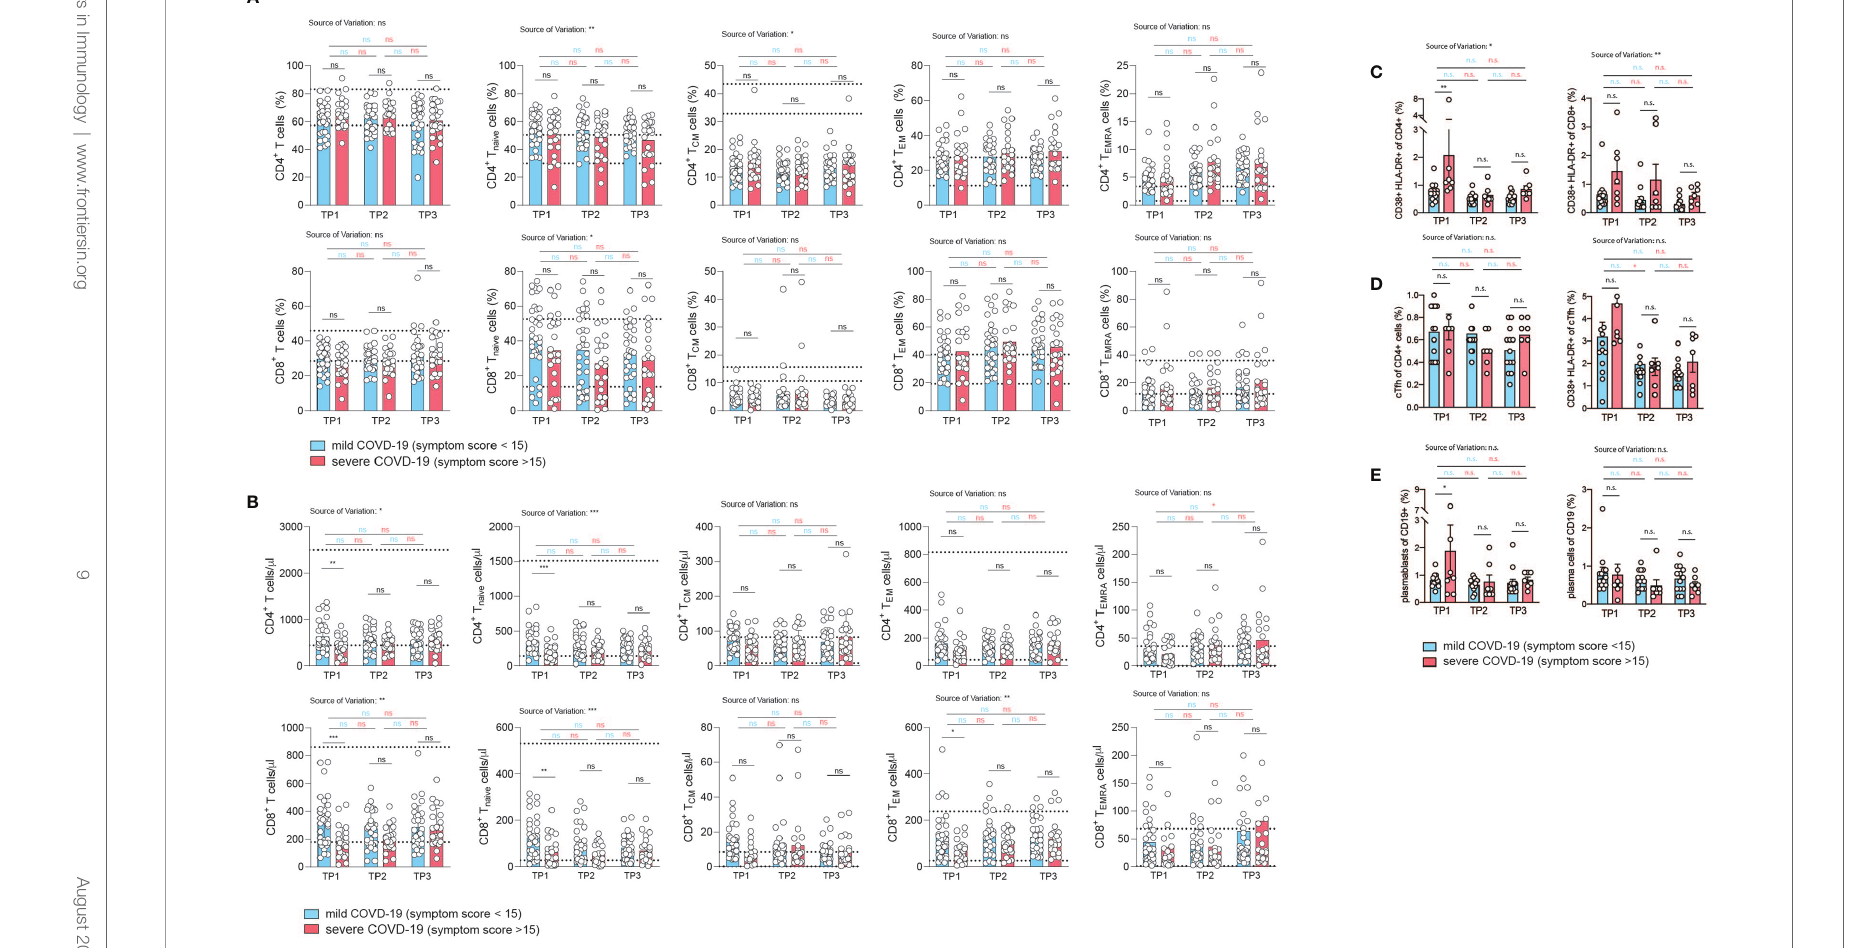
FIGURE 3 | Correlation of COVID-19 severity with T cell differentiation and activation states over time. (A, B) Flow cytometry of ex vivo isolated PBMC gated on CD3 + CD19 – CD56 – gd T cell – CD8 + or CD4 + T cells. T Naive : CCR7 + CD45RA + , T CM : CCR7 + CD45RA, T EM : CCR7 – CD45RA – , T EMRA : CCR7 – CD45RA + . Each circle indicates one patient. (A) relative proportions as determined by manual gating. (B) absolute cell numbers as determined by manual gating. (C – E) Spectral fl ow cytometry of ex vivo isolated PBMC (n=20). (C) Percentage of CD38 + HLA-DR + activated T cells gated on CD3 + CD4 + (left panel) or CD3 + CD8 + T cells (right panel). (D) Frequency of circulating Tfh cells gated on CD3 + CD4 + CD45RA – CXCR5 + PD1 + cells of CD4 + T cells (left panel), percentage of activated CD38 + HLA-DR + cTfh cells (right panel). (E) Frequency of plasmablasts (gated as CD19 + CD27 + IgD – CD38 + CD20lo CD138 – ) and plasma cells (gated as CD19 + CD27 + IgD – CD38 + CD20lo CD138 + ). Gating strategy for all cell subsets from (C – E) is shown in Figure S6 . 2way ANOVA tests with Holm-Sidak ’ s multiple comparisons tests were performed for comparison of mildly versus severely affected patients longitudinally. n.s., not signi fi cant. The dotted lines indicate the range of physiological variations of the respective cell